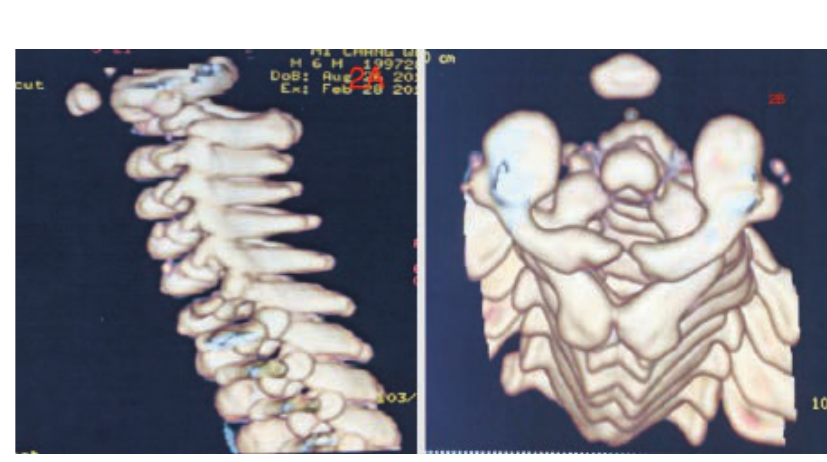
Figure 2. A-B) Are 3D images showing the atlantoaxial dislocation.